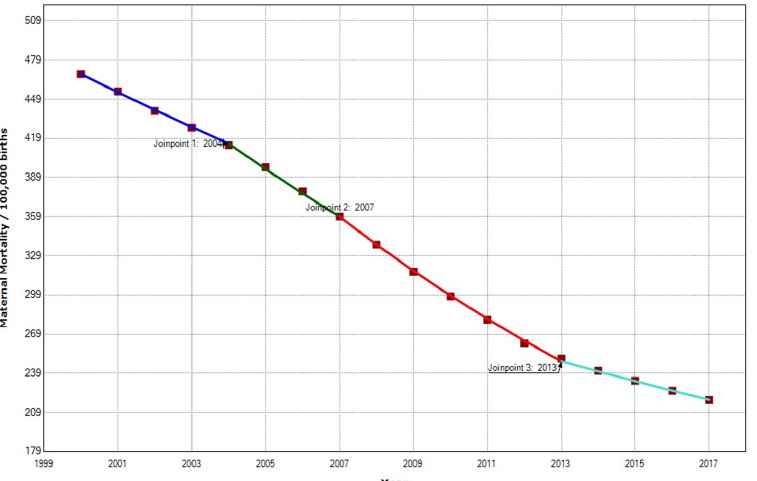
Figure 8. Maternal mortality trends in the South African region (2000–2017) indicate joinpoints at the transitions between colored lines.